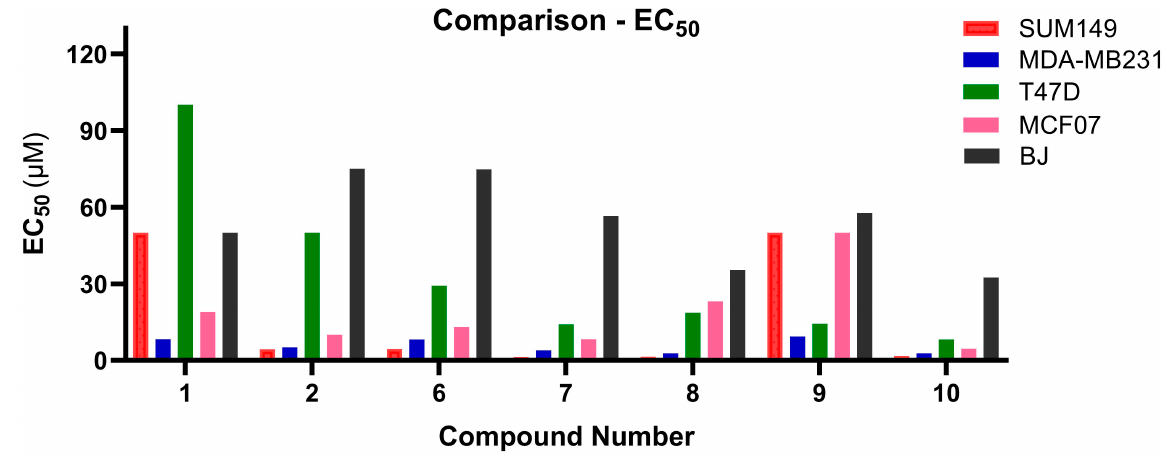
Figure 2. Column bar graphic to compare activities of compounds in the different cell lines.